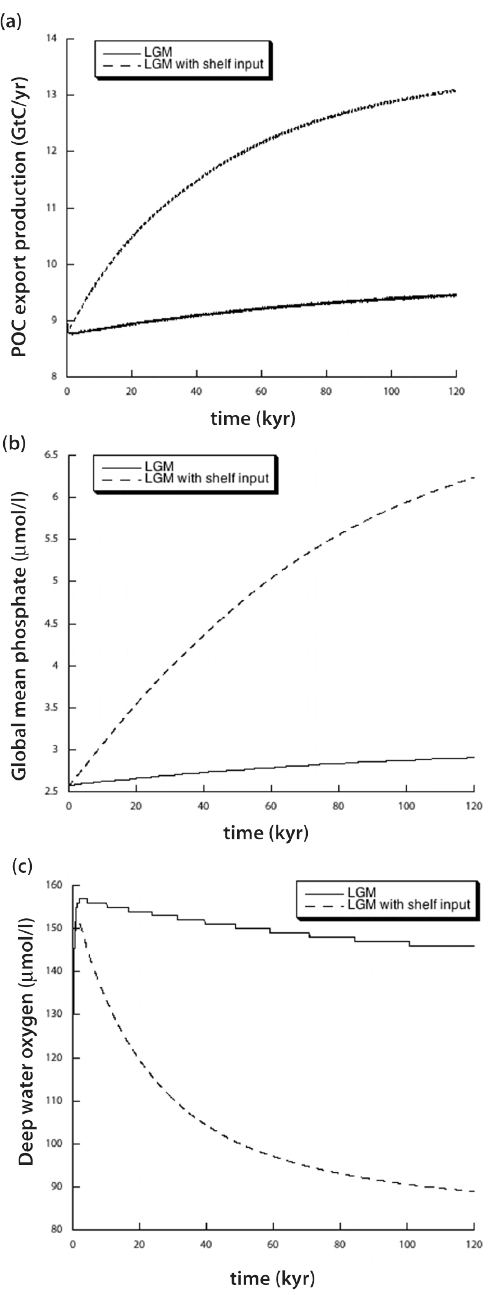
Fig. 5. Transient model response of (a) global POC export produc- tion, (b) global mean phosphate concentrations and (c) mean oxy- gen concentrations at 1000-m depth in the LGM simulation (solid line; LGM) and the LGM simulation with shelf input (dashed line; LGM with shelf